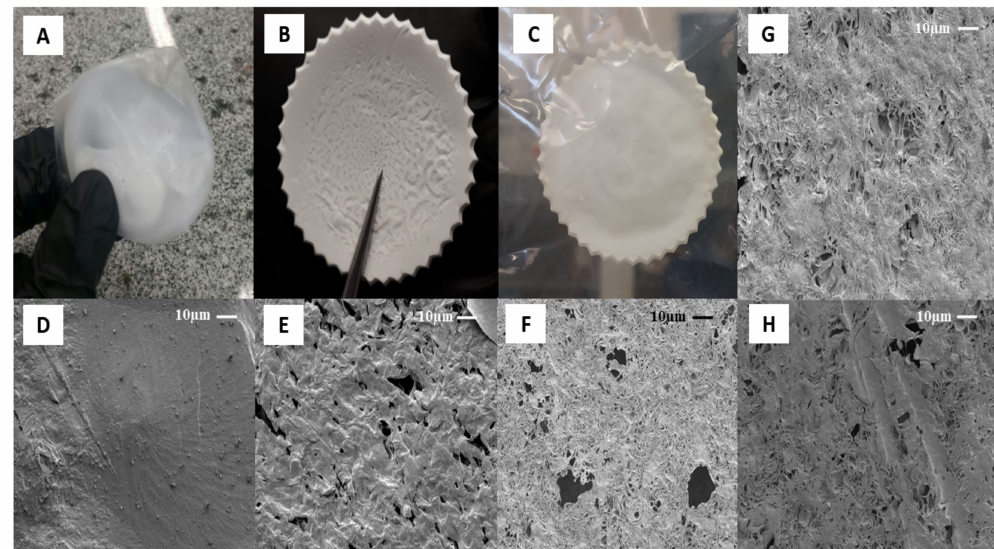
Figure 2. The optical images (OI) and microscopic (SEM) of PCL casting film at magnification 1000 × , respectively: ( A ) PD- control OI; ( B ) PAC-control OI; ( C ) PAcA-control OI; ( D ) PD-control SEM; ( E ) PAC-control SEM; ( F ) PAcA-control SEM; ( G ) PAcA-1.7 SEM; ( H ) PAcA-2.7